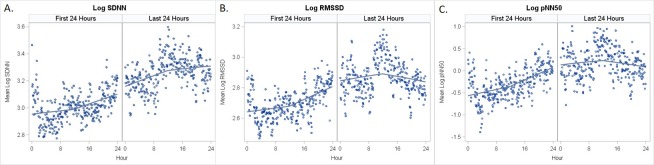
Log heart rate variability over time from PICU admission for first and last 24 hours of PICU stay.Mean HRV for A) SDNN, B) RMSSD, and C) pNN50 displayed from time of PICU admission with HRV from the first 24 hours of PICU stay in the left panel and the last 24 hours in the right panel of each graph. Loess Curves are superimposed.